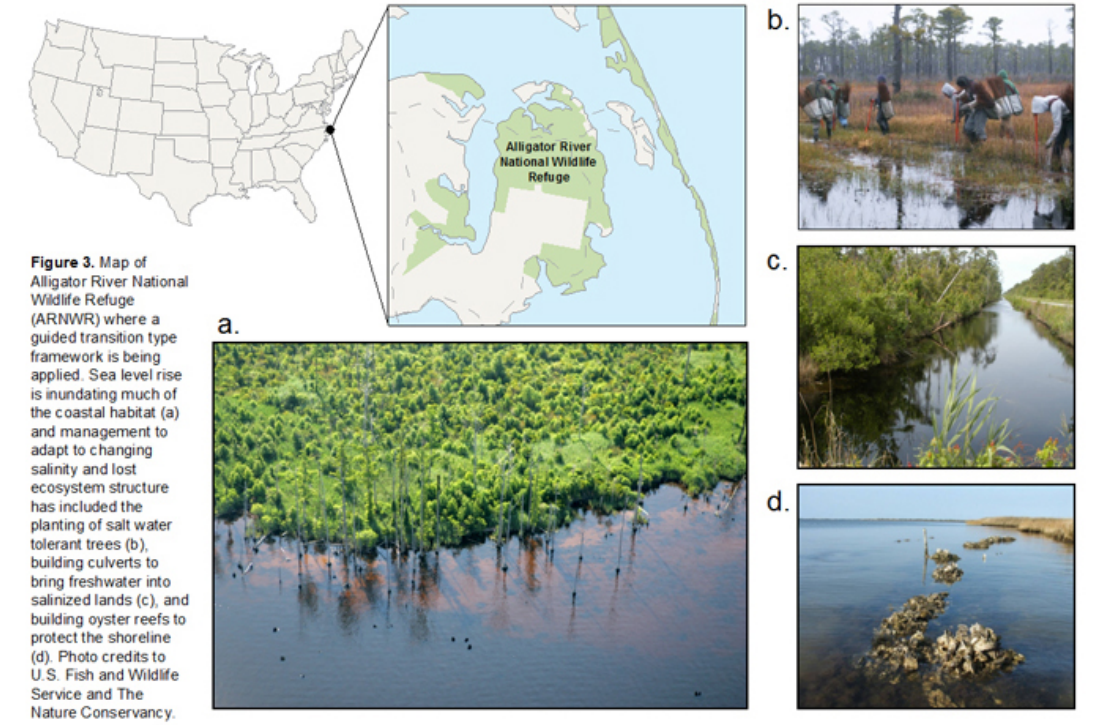
Fig. 3 . Map of the Alligator River National Wildlife Refuge, where a guided transition type framework is being applied. Sea level rise is inundating much of the coastal habitat (a), and management to adapt to changing salinity and lost ecosystem structure has included planting saltwater-tolerant trees (b), building freshwater culverts to bring freshwater into salinized lands (c), and building oyster reefs to protect the shoreline (d). Photo credits: U.S. Fish and Wildlife Service and The